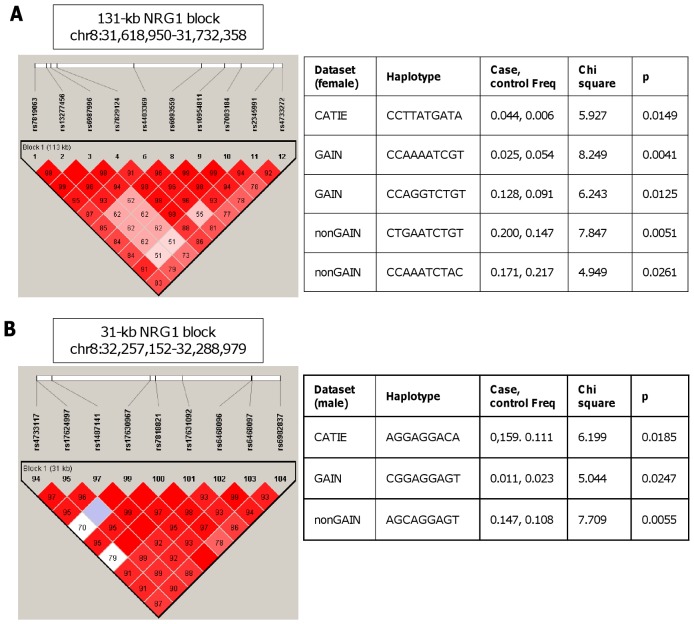
Identification of gender-specific association of NRG1 in schizophrenia GWAS datasets.LD plots of NRG1 with the most significant haplotypes A. in the region from 31,618,950 bp to 31,732,358 bp in females. B. in the region from 32,257,152 bp to 32,288,979 bp in males Cut-off value for Hardy-Weinberg is 0.05 and for minor allele frequencies 0.001.